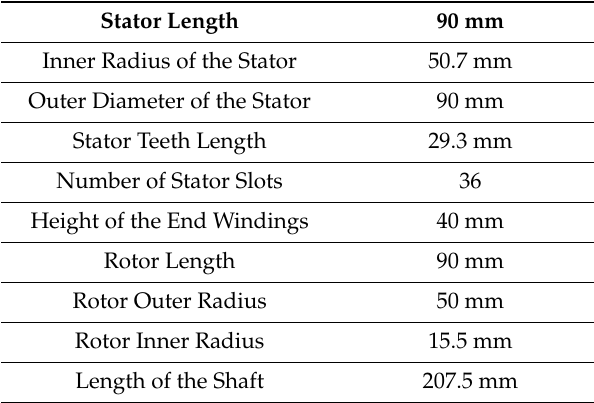
Figure 1. The 3D geometry of the interior permanent magnet IPM motor: ( a ) stator, rotor and shaft with the housing; ( b ) stator, rotor with magnets and the shaft; ( c ) rotor with magnets and shaft; ( d ) shaft only; ( e ) stator with windings; ( f ) dimensions of the stator lamination sheet. Table 1. Geometrical properties of the IPM components.